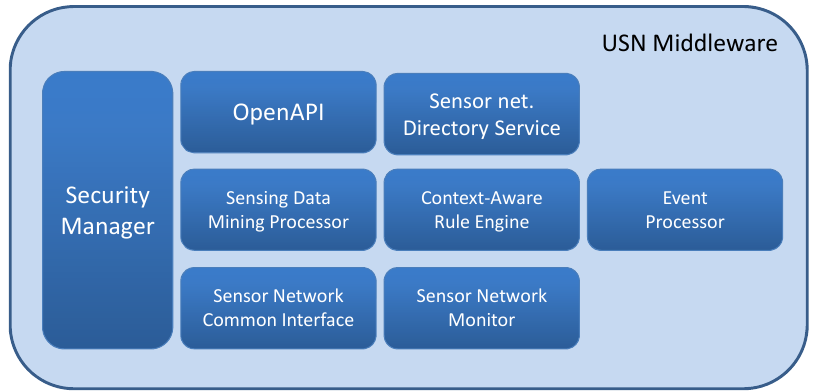
Figure 5. Ubiquitous Sensor Network middleware, as described in [23].